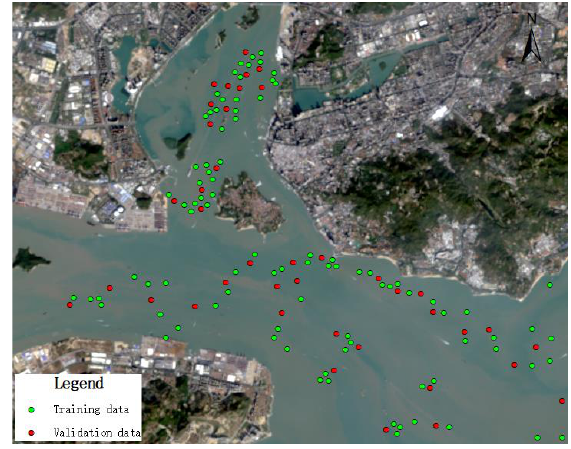
Figure4. Distribution of sample points In clear water area, the effective penetration depth of blue band and green band can exceed 30 m. In the turbid water area, the ability of detecting becomes weaker due to the large attenuation coefficient caused by the turbid water quality (Lafon V,2002 ). The reflectance of near infrared band is low, and it is sensitive to the water depth (Lyzenga D R,2006). The vertical water temperature has a certain relationship with water depth especially in the coastal area. So, the blue band, the green band, the near infrared band, the green band/the blue band and the sea surface temperature is selected as the water depth inversion factor. In order to keep the same resolution, the temperature inversion result is resampled to 30 meters. learning rate was 0.01. The expected error is 0.1. The number of Figure3. Tide correction curve iterations is 30000. The number of hidden layer nodes is 15. The average relative error of training accuracy is 0.11. The root mean square error of training accuracy is 0.99. Through this model, the inversion of water depth in the study area is realized. After the tide correction, the water depth inversion results are shown in the figure